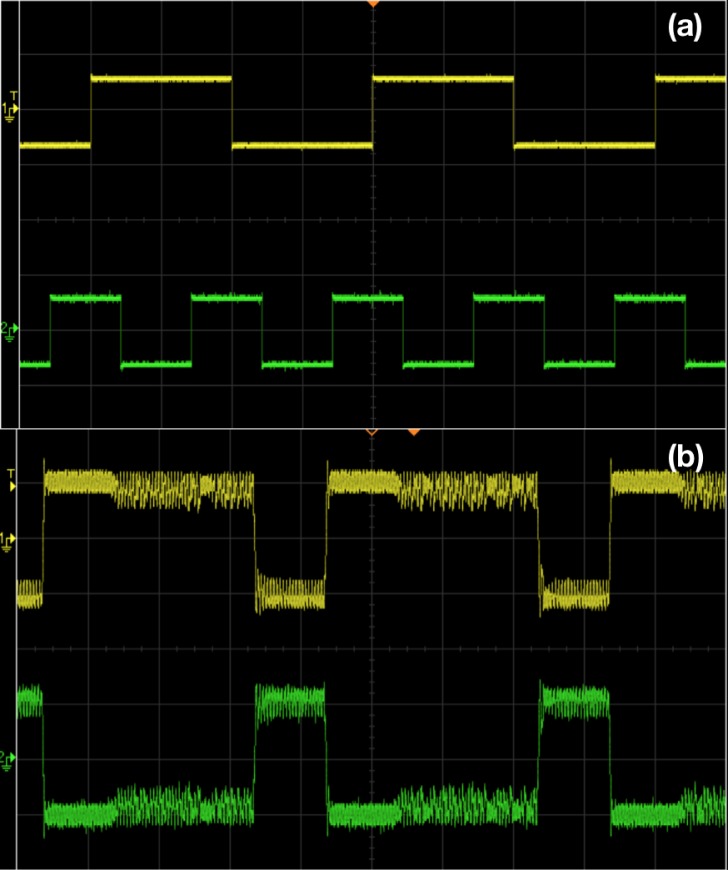
Realization of OR/NOR logic gates through chaotic attractor hopping in electronic circuit experiments.Panel (a) shows stream of inputs I1 and I2 (which take value −10 mV when logic input is 0 and value 10 mV when logic input is 1). Panel (b) shows the voltage V(t) (yellow) clearly indicating a logical OR output (with V(t) > 0 being logic output 1, and V(t) < 0 being logic output 0). The output voltage VL (green) yields the complementary NOR logic gate response. The amplitude A of the sinusoidal signal is 150 mV and frequency is 8890 Hz. The bias voltage b, is fixed as 10 mV. For panel (a), the scale in the traces are: 20 mV/Div (Y-axis) and 5 mS/Div (X- axis). For panel (b), the scale in the traces are: 100 mV/Div (Y-axis) and 5 mS/Div (X- axis). The oscilloscope used is Agilent or Keysight DSOX2012A.